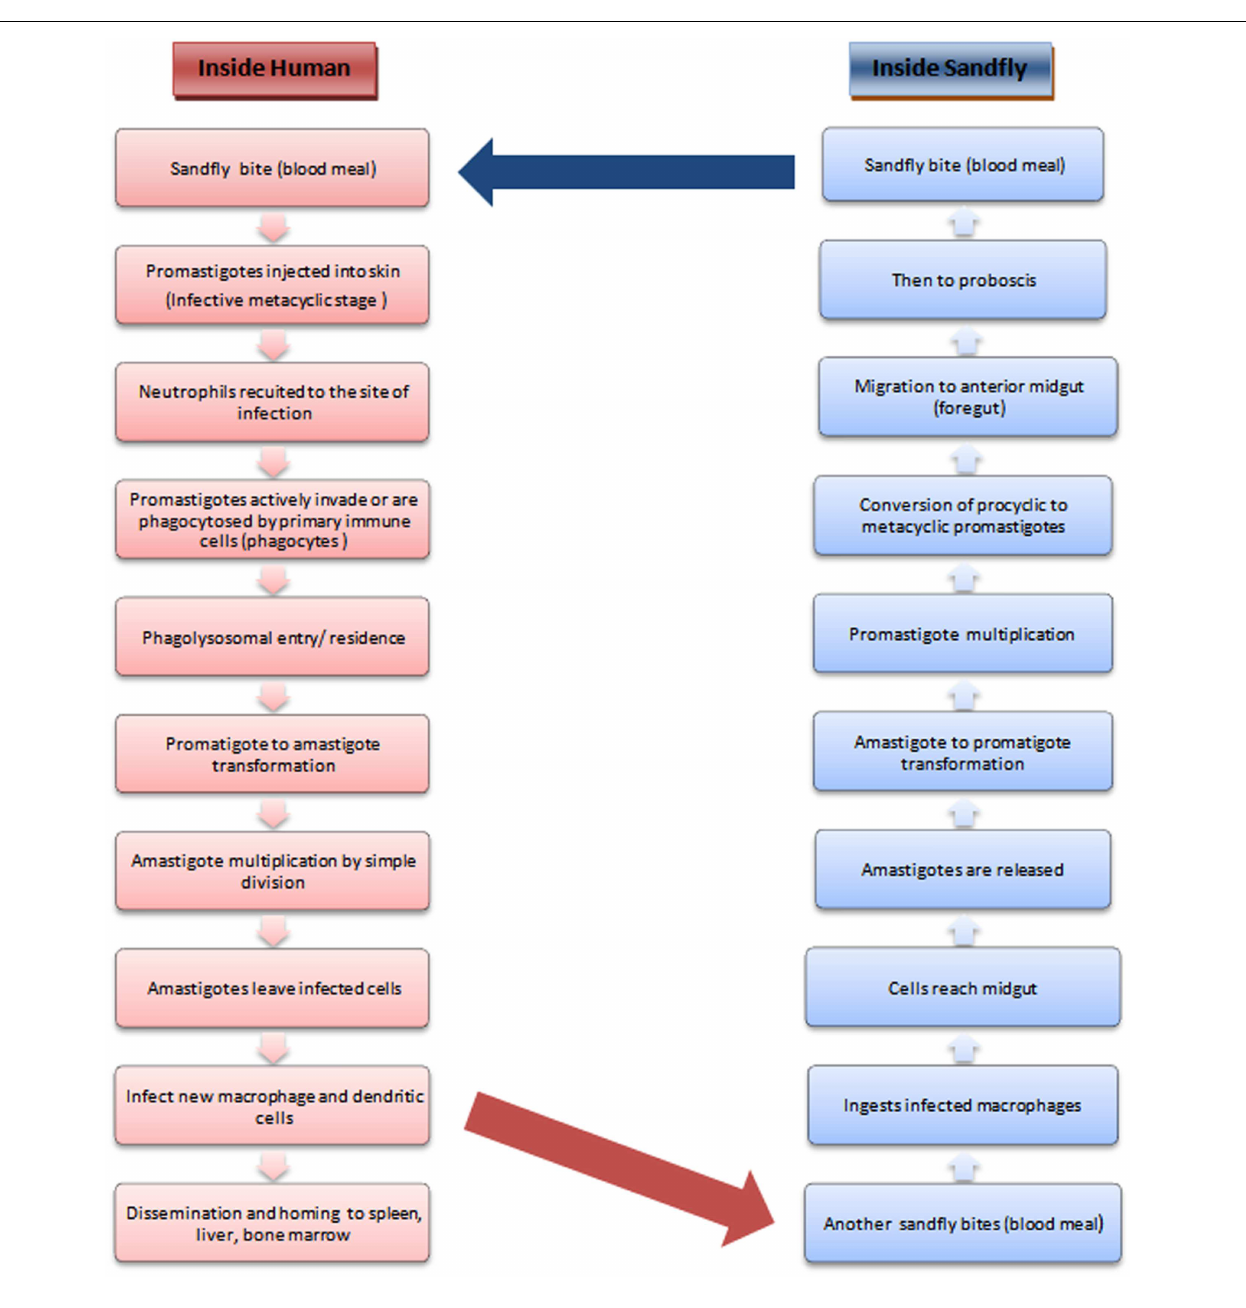
FIGURE 1 | Life cycle of Leishmania